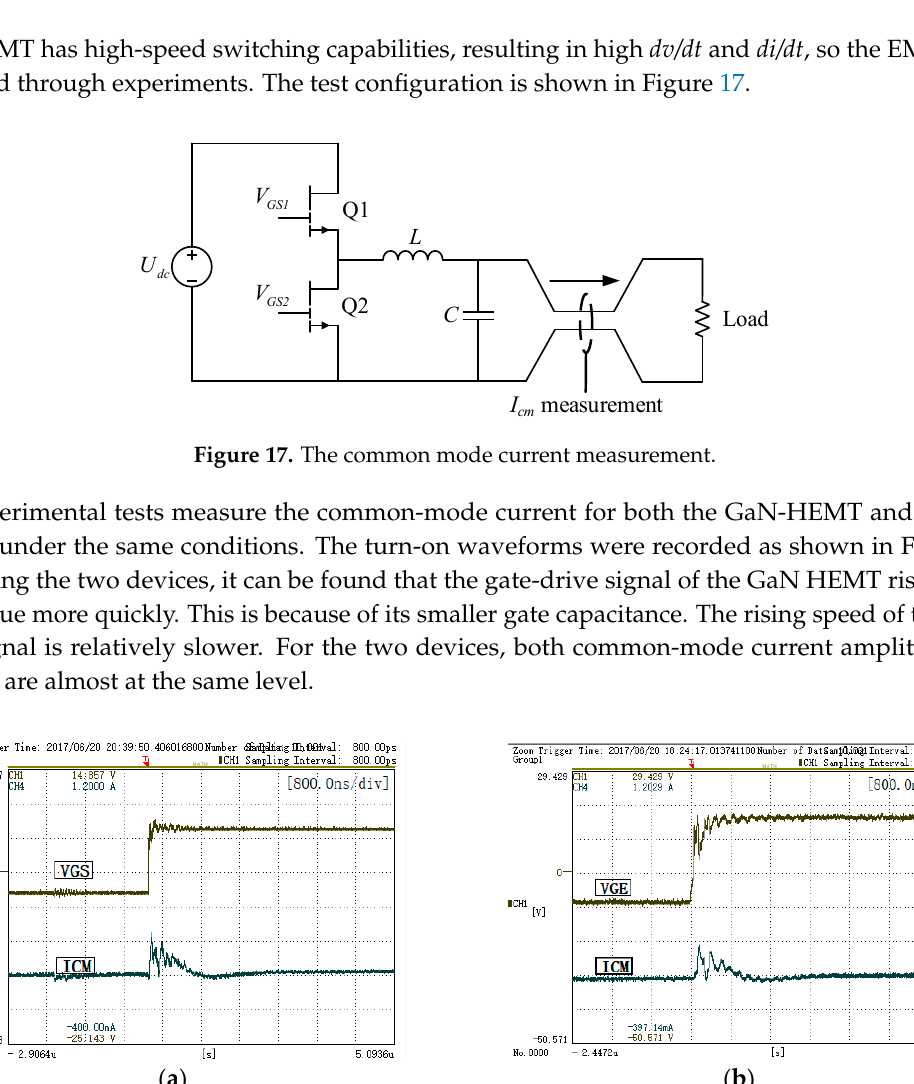
Figure 16. Buck circuit efficiency.